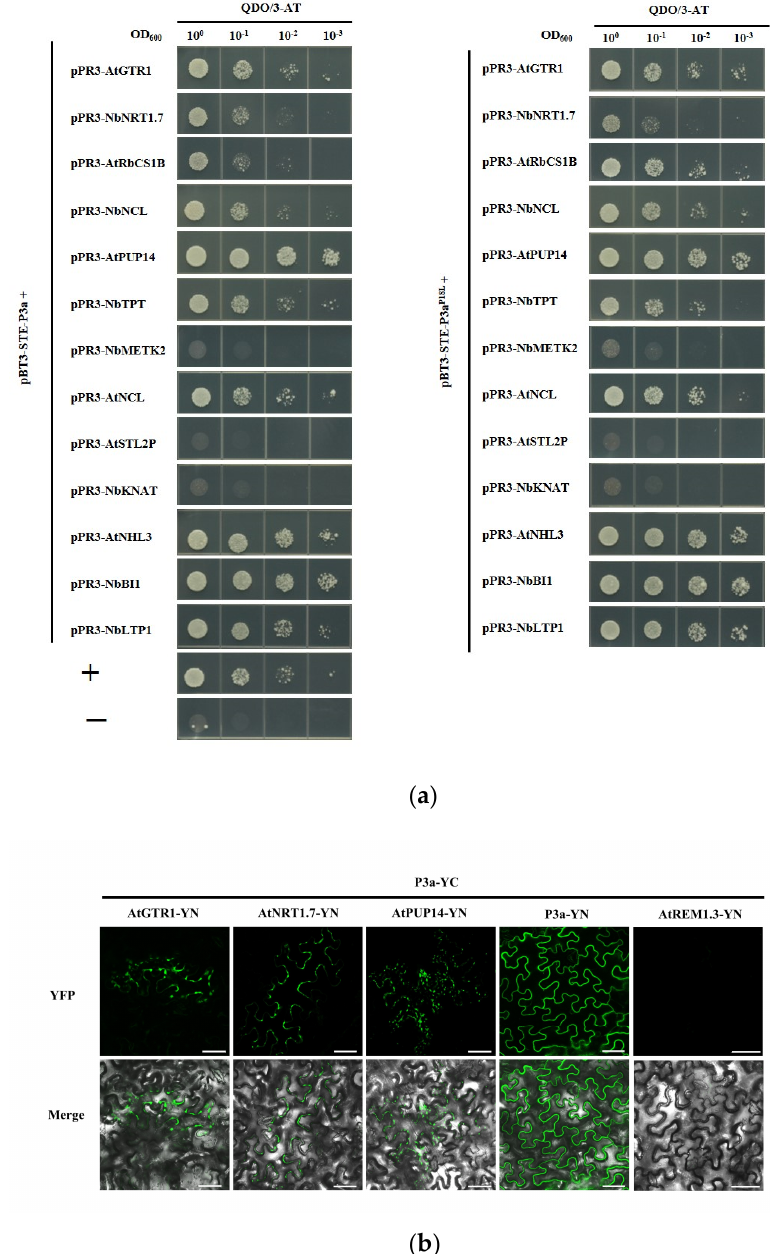
Figure 2. Verification of the interactions between P3a (P3a P18L ) and screened host factors. ( a ) Analysis of the interactions between P3a(P3a P18L ) and 13 screened host proteins in the MYTH system. The interactions were indicated by yeast growth on QDO/30 mM 3-AT. P3a self-interaction and pPR3-N + pBT3-STE-P3a served as the positive and negative controls, respectively; ( b ) BiFC assay of interactions between P3a and the three candidate interacting proteins. Self-interaction of P3a served as a positive control. AtREM1.3-YN with P3a-YC served as a negative control. Scale bars = 50 μM.